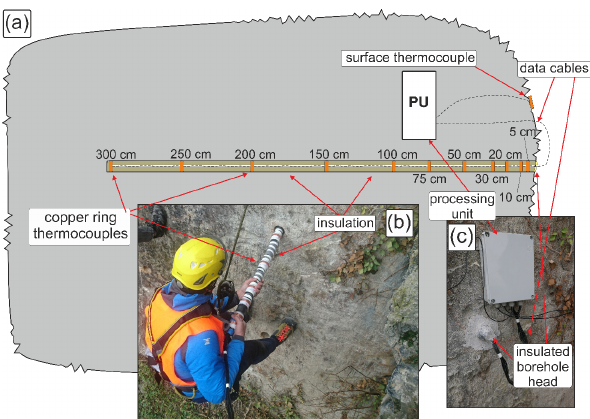
Figure 2. Compound borehole thermocouple probe: (a) generalised scheme, (b) photo of compound thermocouple probe installation, (c) insulated head of a subhorizontal borehole with a processing